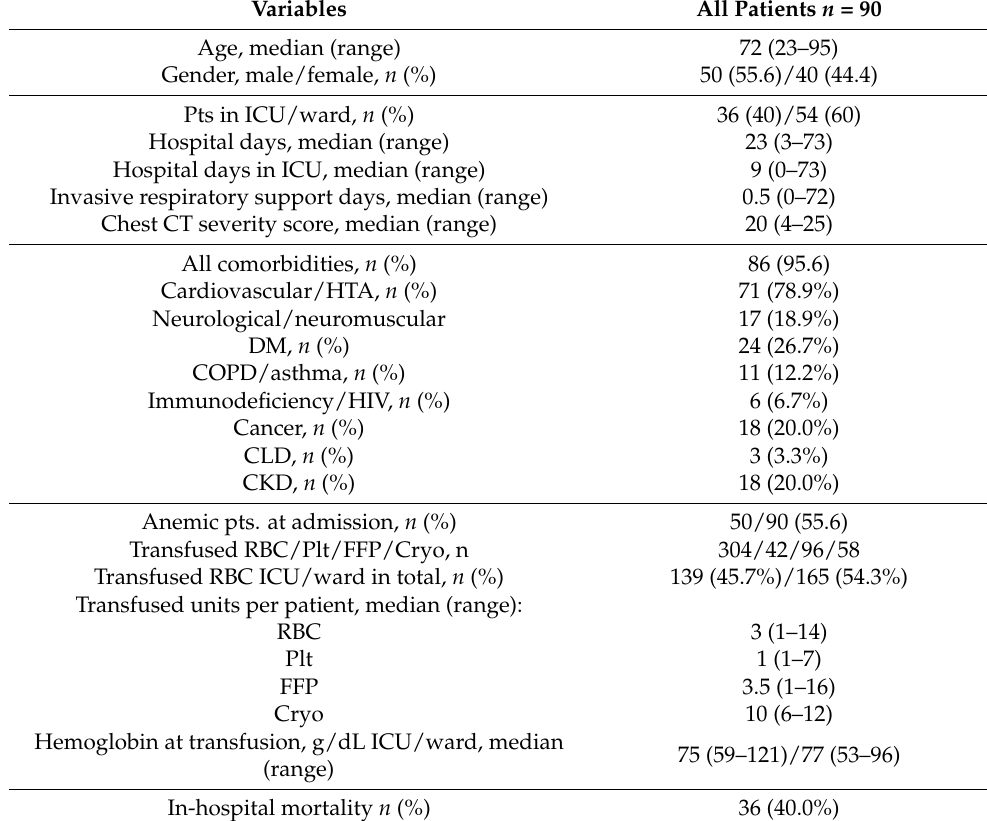
Table 1. Baseline and transfusion data of the